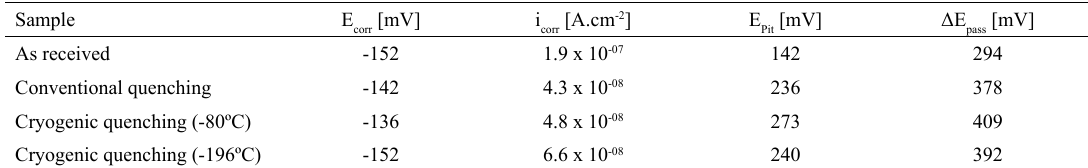
All polarization curves develop the same profile (Figure 8), which reveals the same corrosion behavior. The Tafel extrapolation values (Table 7) demonstrate the decrease of i for the heat-treated samples. However, deep heat corr treatment is not steadily gaining acceptance as a process for Table 7. Tafel extrapolation results, pitting and passive